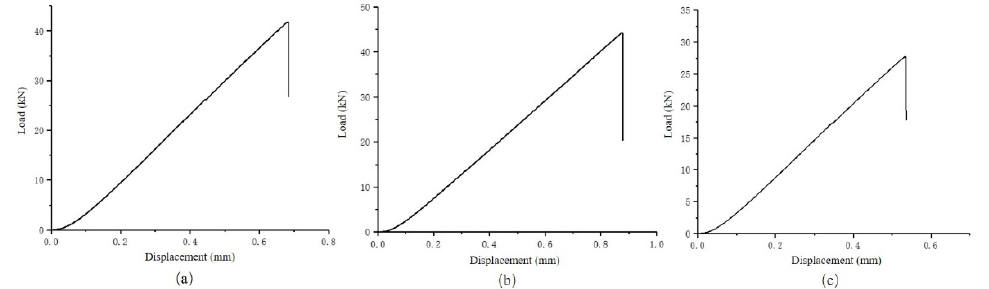
Figure 10. Load-displacement diagram of the failure test that corresponds to three kinds of shale fracture modes: ( a ) splitter fracture corresponding to the failure test (S0); ( b ) arrester fracture corre- sponding to the failure test load-displacement diagram (A0); ( c ) divider fracture corresponding to the failure test (D0). Table 2. Compression test results of three modes of non-cracked shale specimens.